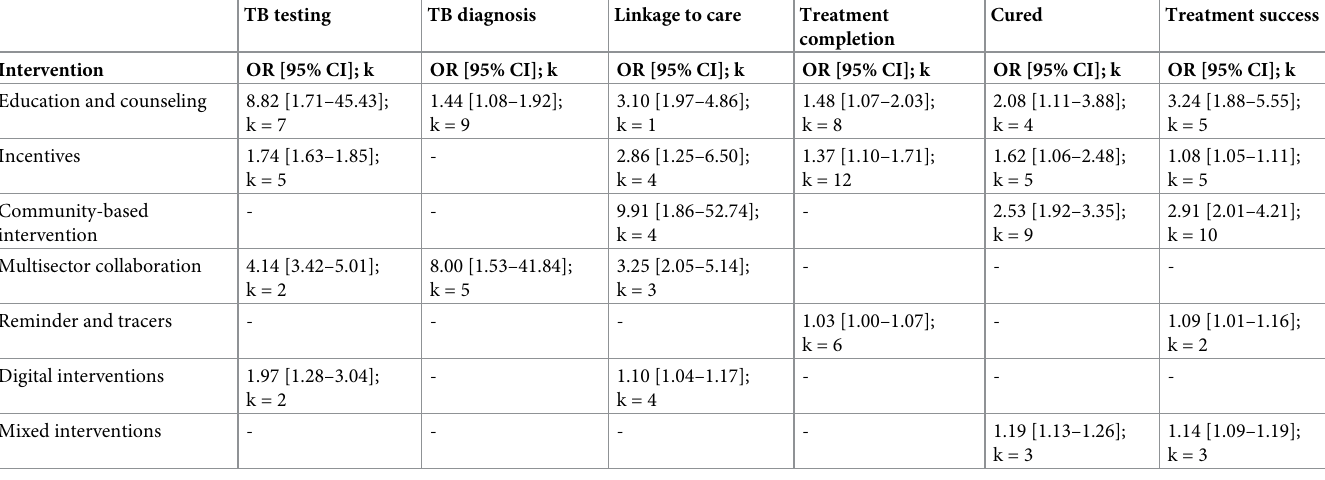
Table 4. Interventions significantly associated with TB care outcomes at multiple stages of the TB care cascade.